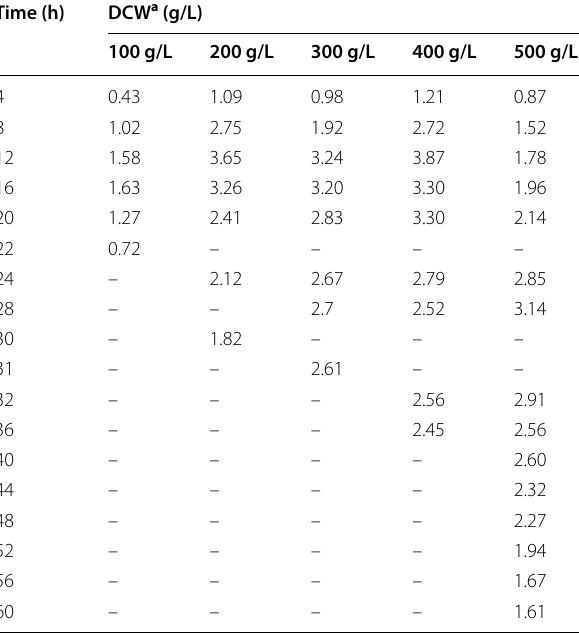
a The average value from three parallel tests